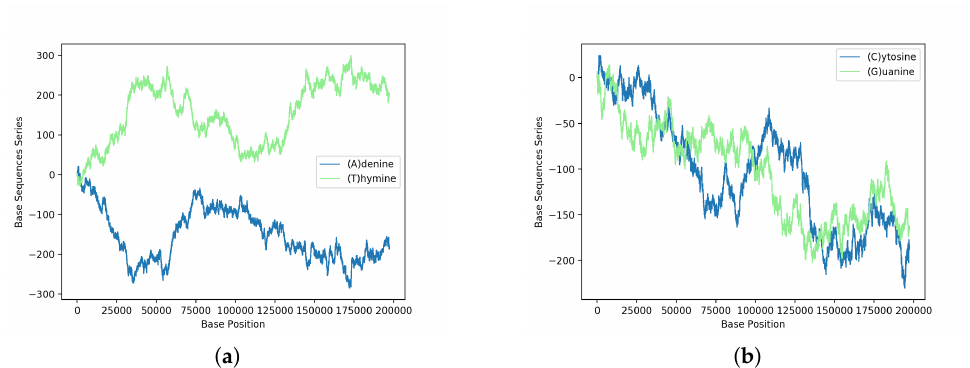
Figure 1. GenomeBits imprints of the genome sequence monkeypox virus isolated in the United States MPXV_USA_2022_MA001 (GenBank ID ON563414.3): ( a ) Results according to the pairing rules A-T and ( b ) pairing rules